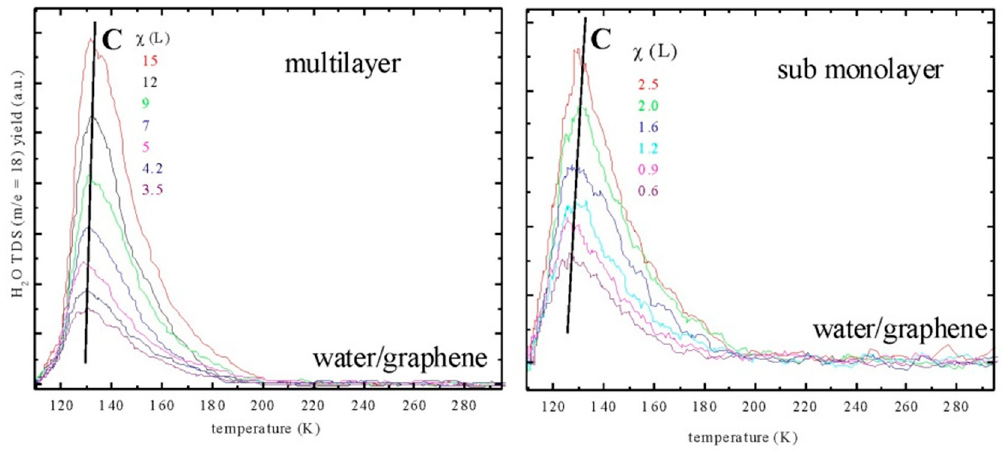
Figure 1. Adsorption of water on physical vapor deposited graphene/Ru(0001), as studied by water thermal desorption spectroscopy (TDS). Condensation peak is labeled as C-peak. Exposure, χ (L), is given in Langmuir (1 L = 1 × 10 − 6 torr·s). (Data from [11])